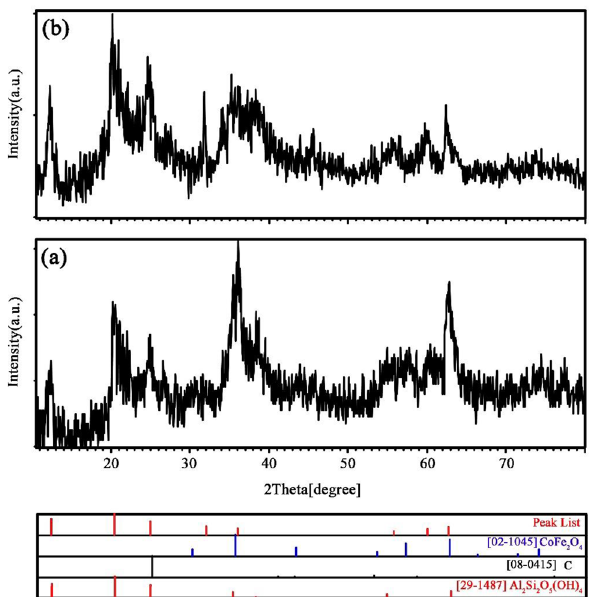
Figure 3. XRD diffractograms of ( a ) CoFe 2 O 4 /HNTs and ( b ) CoFe 2 O 4 /S, N-GQD/HNT